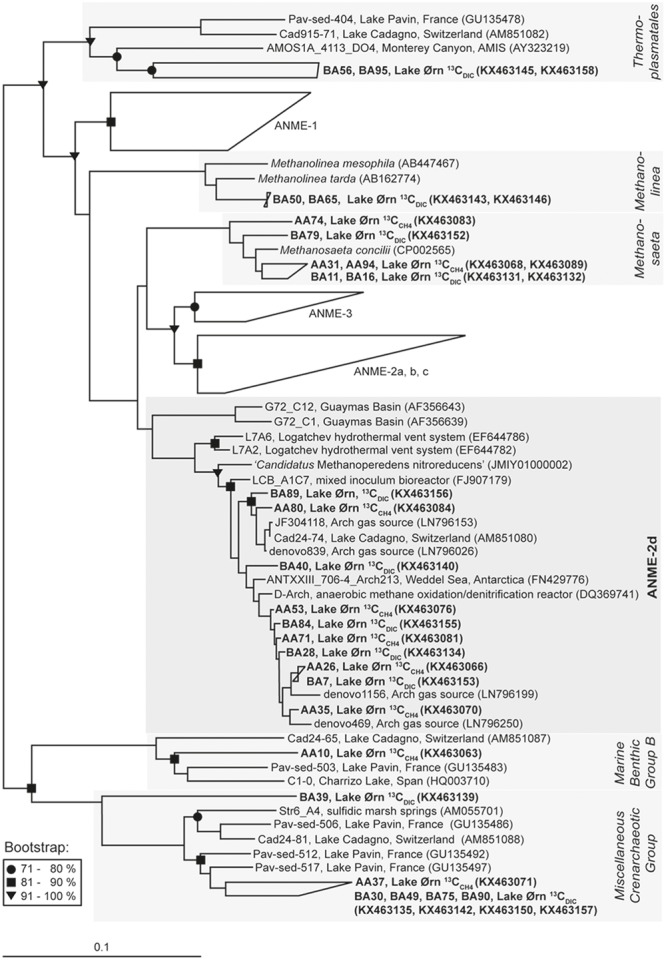
Neighbor-joining 16S rRNA phylogenetic reconstruction for 13C-labeled sequences obtained from 13CCH4 and 13CDIC RNA stable isotope probing incubations and nearest related phylogenetic groups with Hydrogenobaculum acidophilum as outgroup; in brackets: Gene Bank accession numbers. For the cluster ANME-2d 10 of 39 sequences were chosen for display. Bootstrap values (%) represent the percentage of 1000 repetitions and scale bar shows 10 % distance.